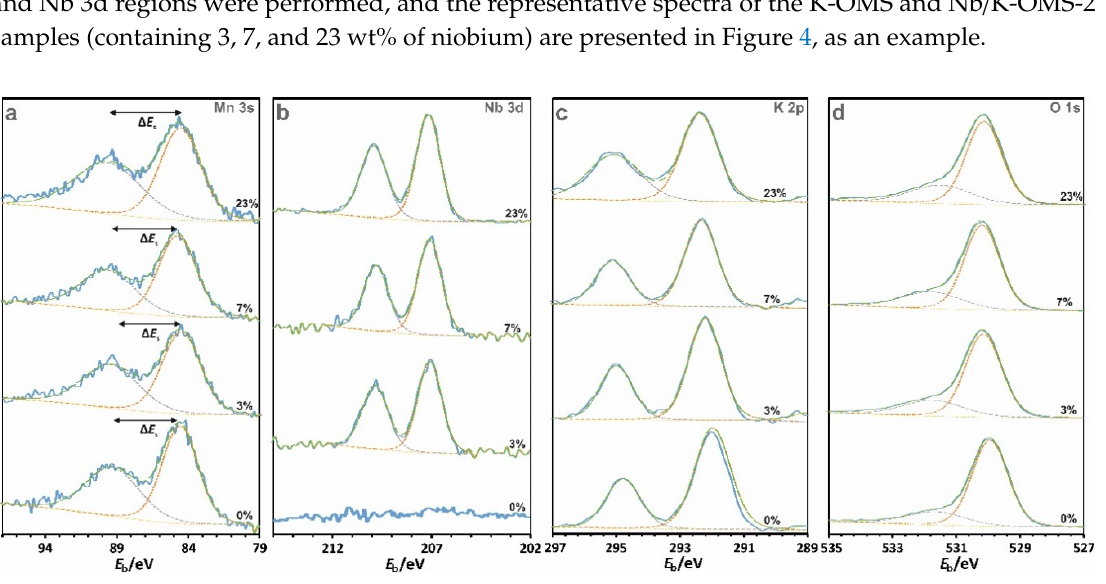
Figure 4. High resolution spectra of Mn 3s ( a ), Nb 3d ( b ), K 2p ( c ), and O 1s ( d ) regions on the surface of Nb/K-OMS-2 catalysts with various amounts of niobium .